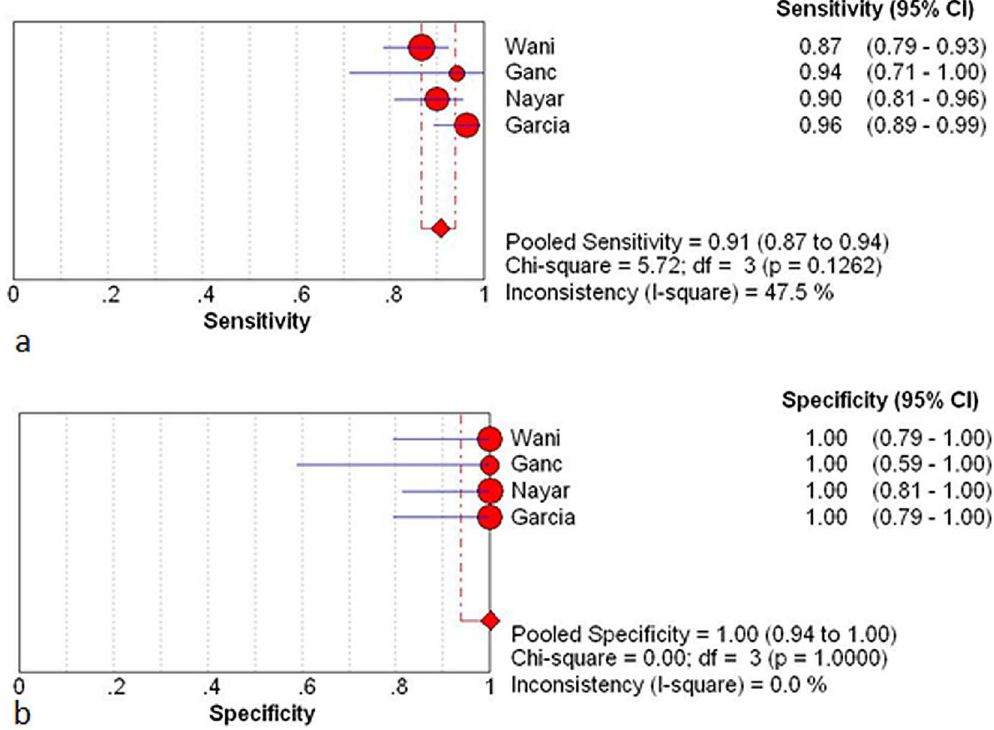
Fig 6. Results for the ROSE group in individualstudies and from pooleddata shown as forest plots for: a sensitivity; b specificity. The I 2 result for heterogeneity is also stated (CI, confidence interval; df, degrees of